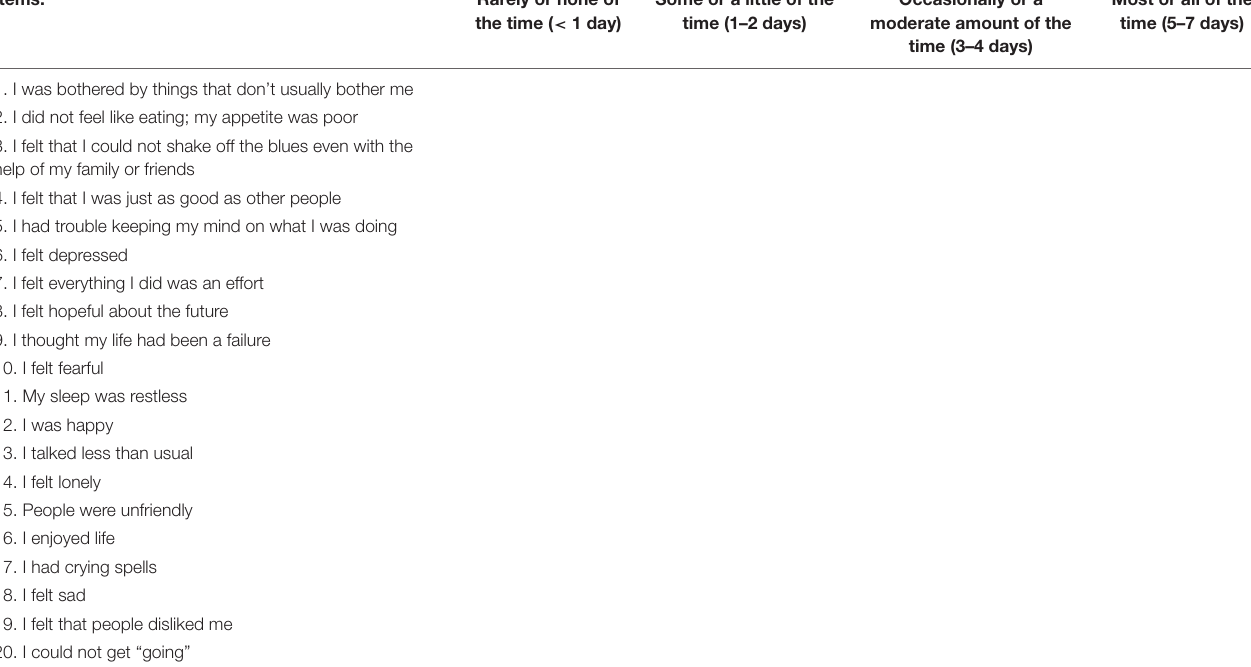
TABLE A1 | Center for Epidemiologic Studies Short Depression Scale (CES − D 20).